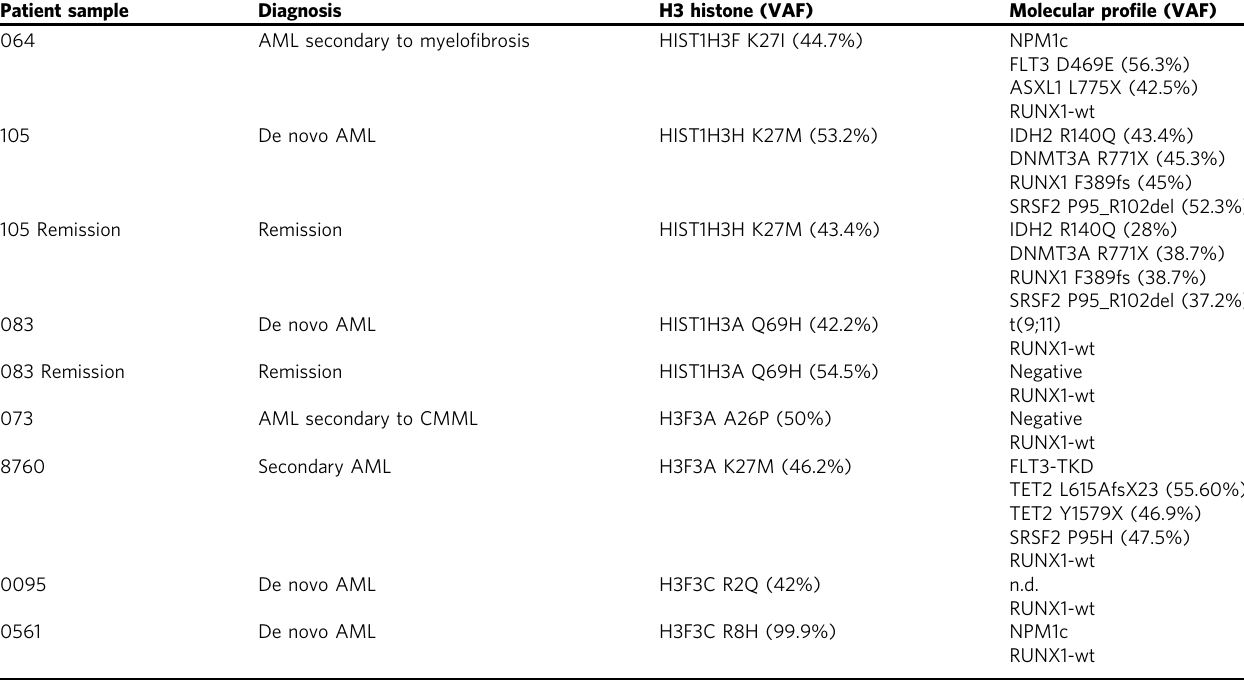
Table 1 Histone mutations in 434 primary human AML samples by MiSeq or exome sequencing Patient sample